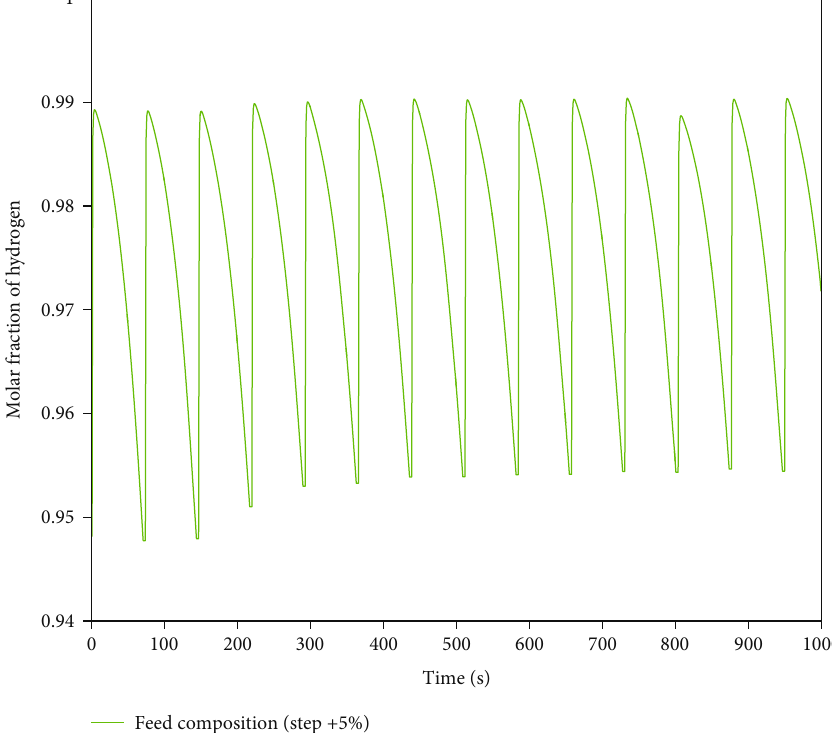
Figure 8: Sensitivity analysis applied to the PSA process for the production of biohydrogen